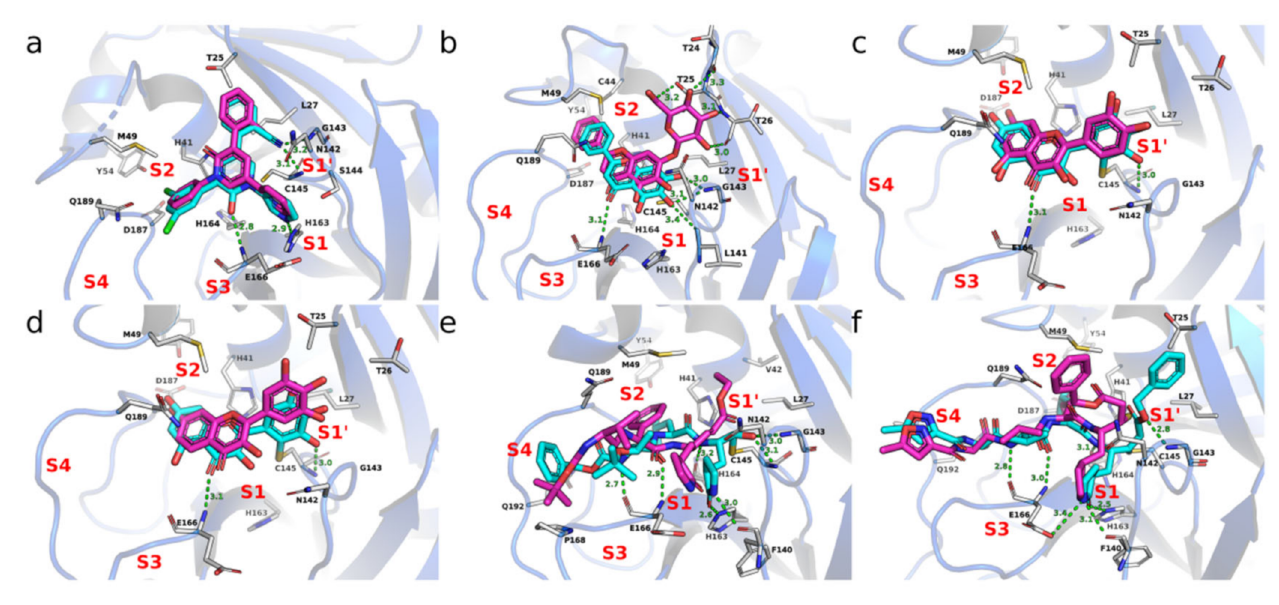
Figure 5. The binding modes of CADD recommended compounds of Mpro compared with the corresponding co-crystallized structures. The CADD recommended compounds are colored in ma- genta, including perampanel ( a ), Baicalin ( b ), quercetin ( c ), robinetin ( d ), DB04692 ( e ) and compound- 23727975 ( f ). The co-crystallized inhibitors are colored in cyan, including COMPOUND4 ( a ), Baicalein ( b ), Myricetin ( c , d ), MPI6 ( e ), and N3 ( f